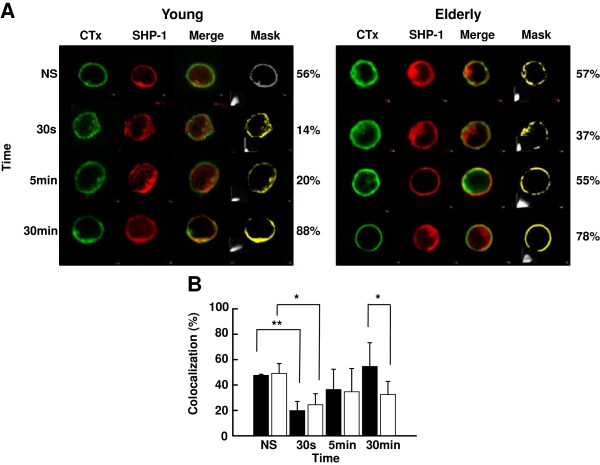
Confocal analysis of the distribution of SHP-1 in plasma membrane lipid rafts. (A) Analysis of the distribution in lipid rafts of cholera toxin B subunit (CTx) and SHP-1 of non-stimulated (NS) and activated (anti-TCR/anti-CD28 mAbs, 5 μg/ml each) T cells of young and elderly donors for various periods of time. An illustrative example of individual, merged images and masking is shown. (B) Colocalization data showing results of T cells of young (filled columns) and elderly (empty columns) donors. Data are represented as the mean ± SD of pixel intensities determined by masking. The asterisks indicate significance (Student’s t-test) for p < 0.05 (*) and p < 0.01 (**). Data are representative of one of 20 independent experiments.